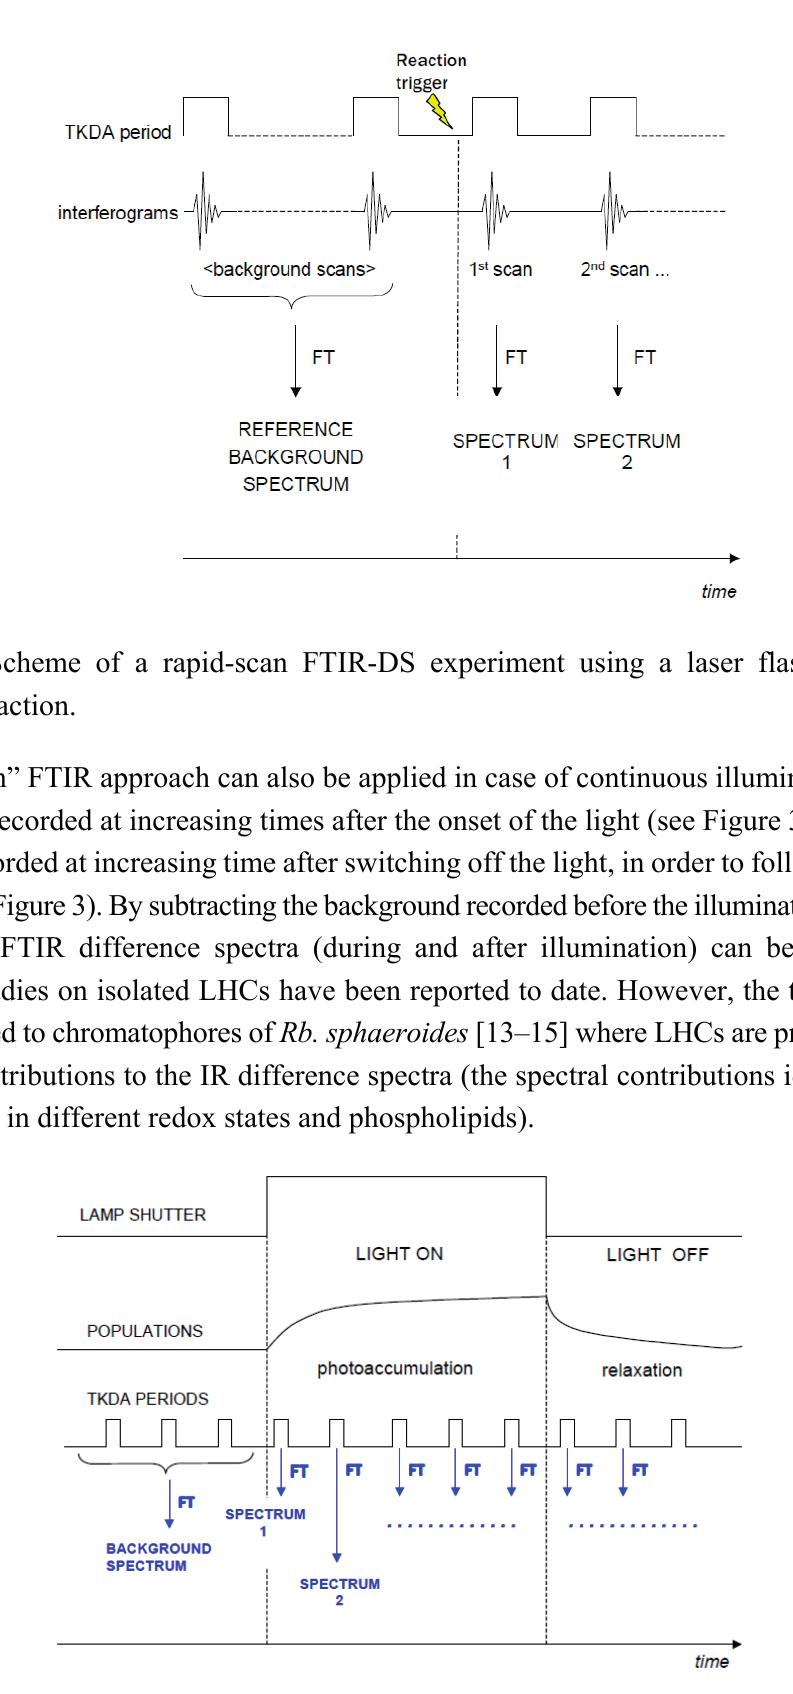
Figure 3. Scheme of a rapid scan FTIR-DS experiment during and after continuous illumination for a hypothetical photoreaction. TKDA periods indicate the time windows during which the interferograms are